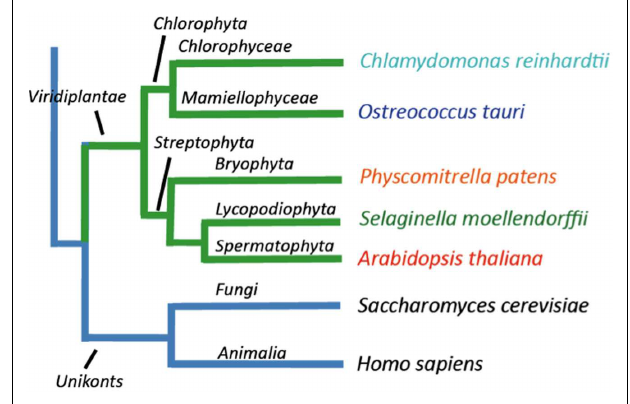
FIGURE 1 | Overview of the evolutionary relationship between the green plant genomes analyzed in this